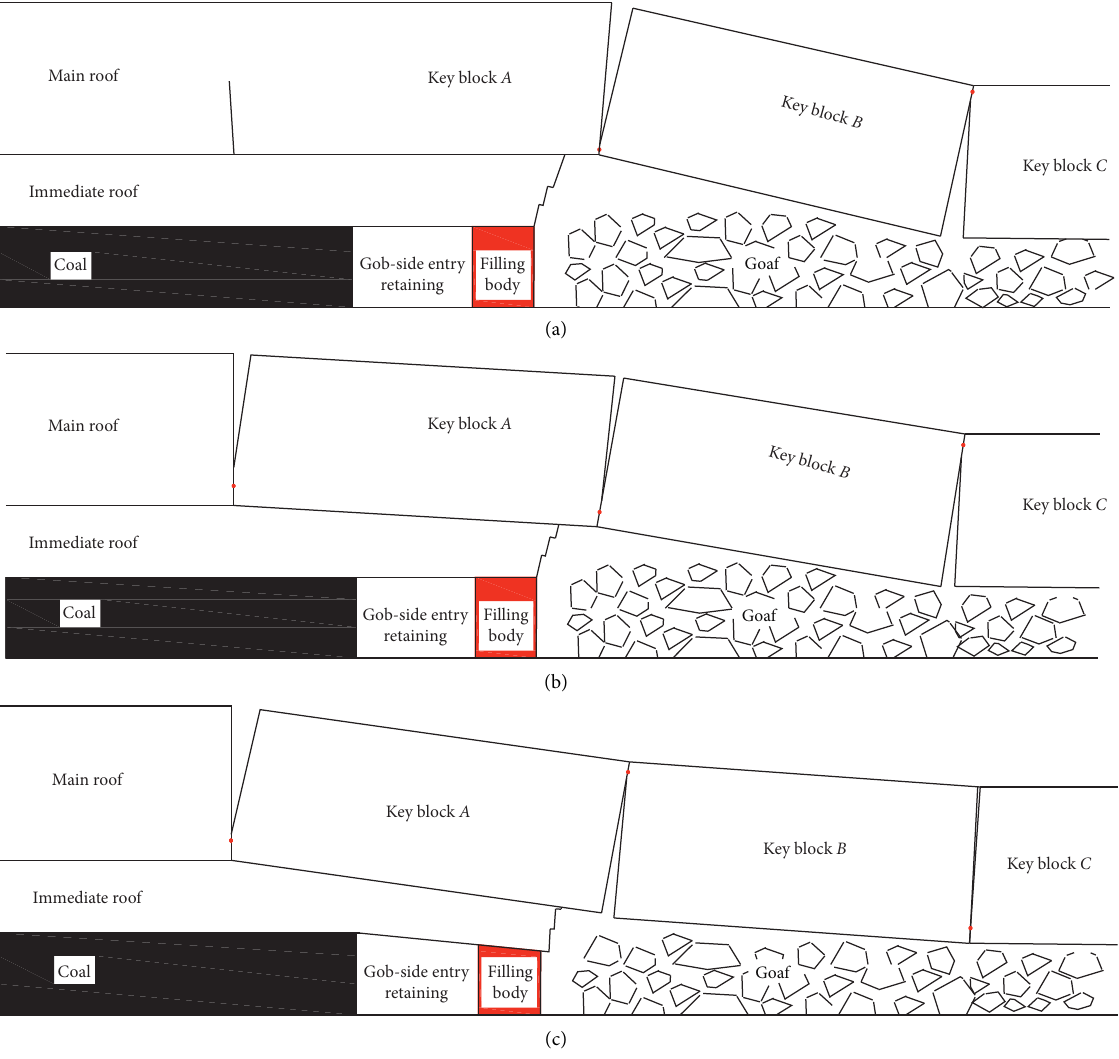
Figure 2: Structure form of short cantilever-articulated rock beam. (a) Roof structure in the stage of gob-side entry retaining, (b) roof structure in the early stage of reuse of gob-side entry retaining, and (c) the roof structure in the late stage of reuse of gob-side entry